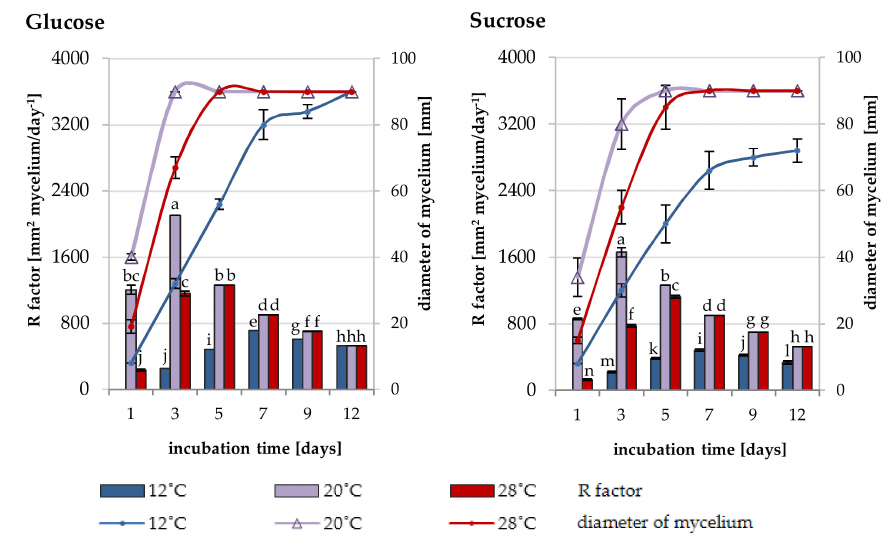
Figure 2. The growth of Trichoderma DEMTkZ3A0 strain on solid mineral Reyes and Byrde (RB) [90] medium supplemented with 1% glucose or 1% sucrose expressed as colony diameter and the growth rate (factor R) changes during 132 day incubation at three temperature 12, 20, and 28 ◦ C.